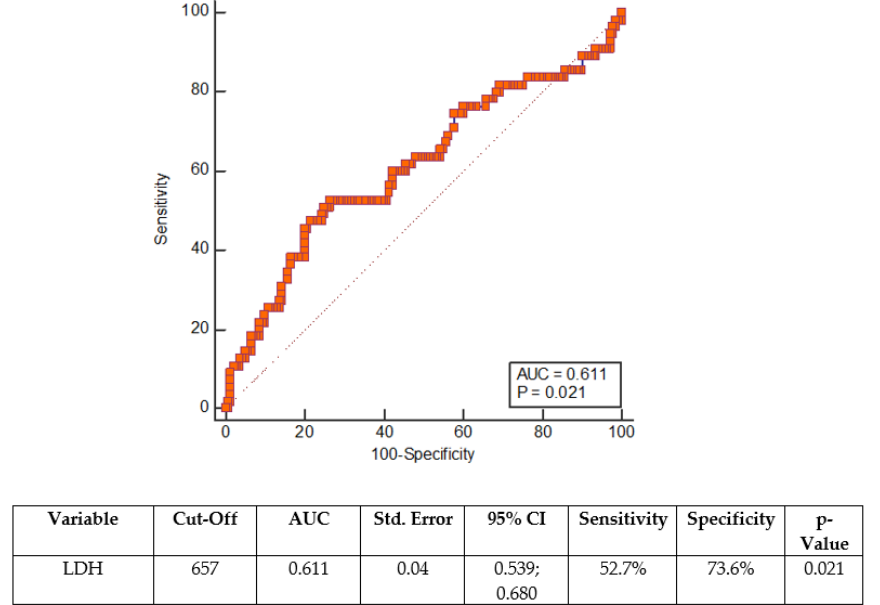
Figure 2. ROC curve for LDH at admission. AUC—area under the ROC curve, ROC—receiver operating characteristics, CI—confidence interval.